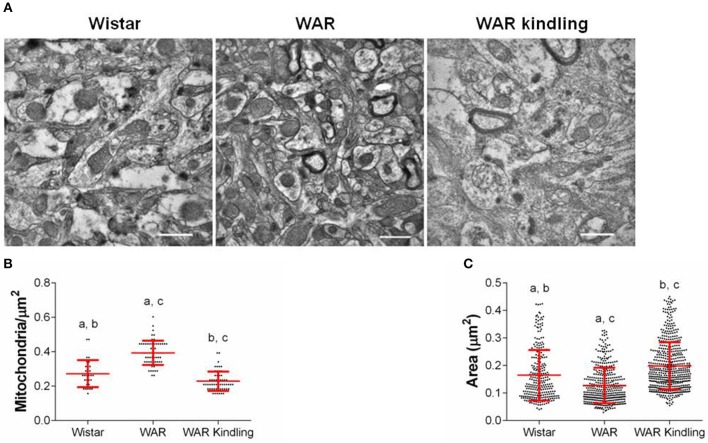
Mitochondrial density and morphology in hippocampus from WAR and Wistar rats (naïve) or WAR submitted to chronic stimulation (kindling). (A) Representative electron micrographs, quantifications of mitochondrial (B) density, and (C) area. Data represent mean of >300 mitochondria (>15 fields of view for 2 rats) ± S.D. for the dot plot graphs.